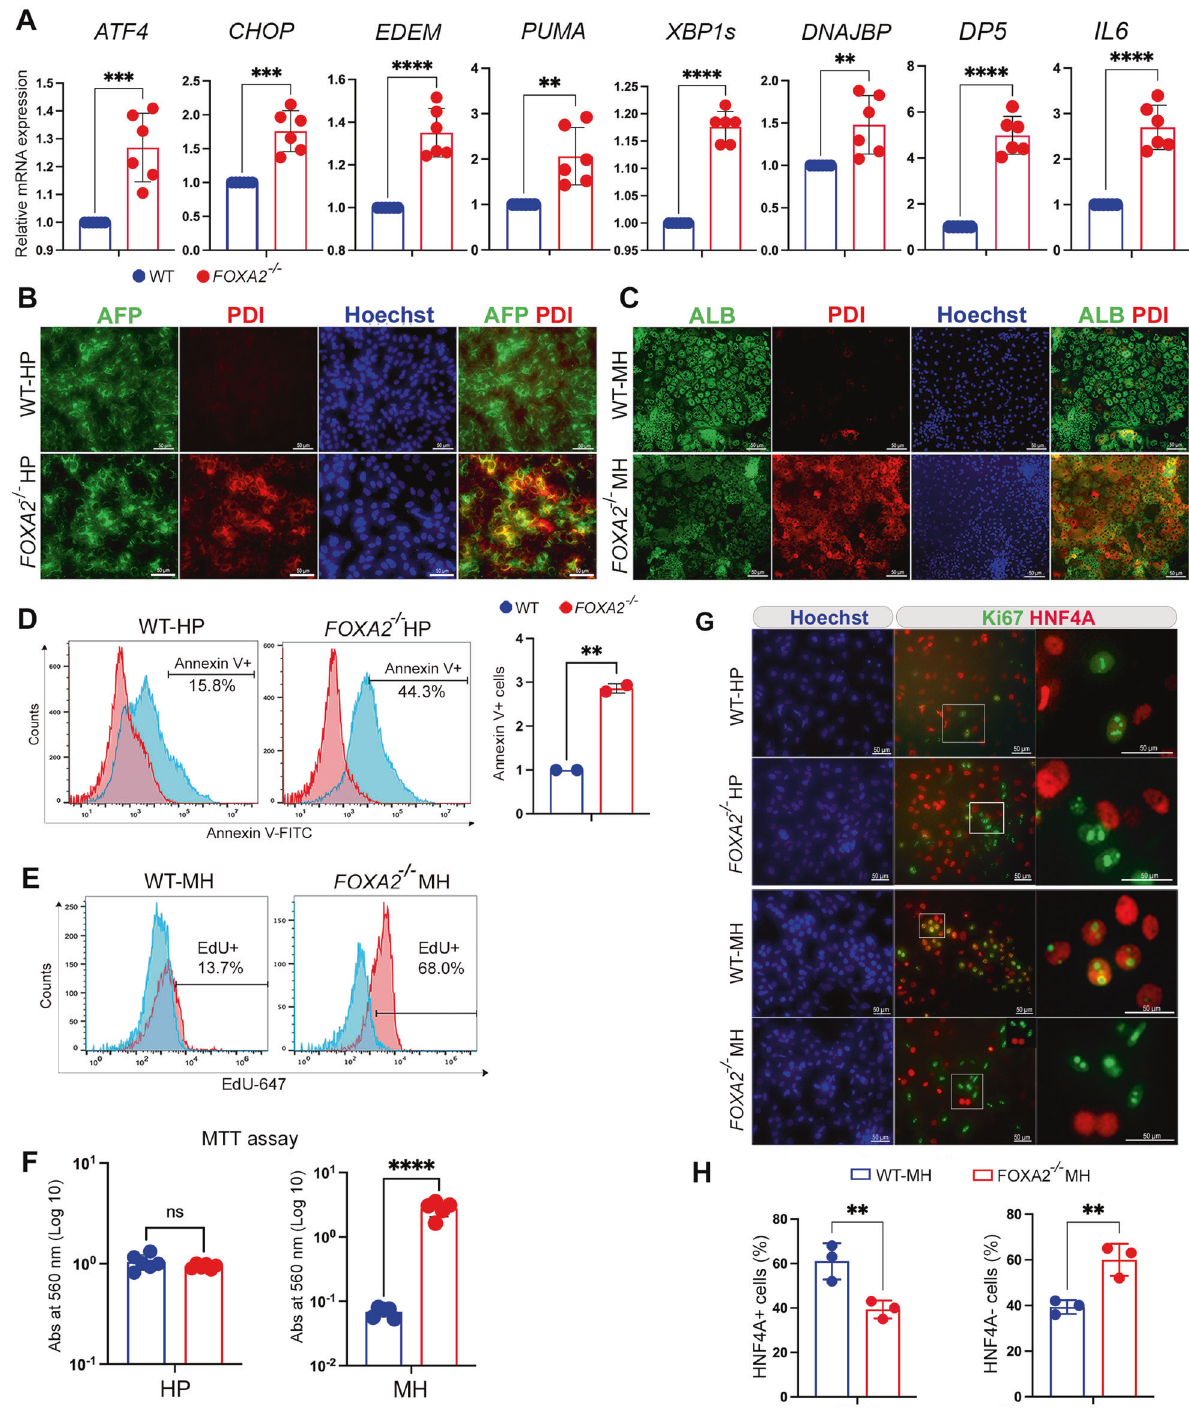
Fig. 3 Effect of FOXA2 ablation on ER-stress markers, apoptosis, and proliferation in iPSC-derived hepatocytes. A RT-qPCR analysis showing the expression of ER stress genes, ATF4 , CHOP , EDEM , PUMA , XBP1s , DNAJBP , DP5 , and IL6 in hepatic progenitors (HP) derived from FOXA2 − / − iPSCs and WT controls ( n = 6). B Immuno fl uorescence showing co-expression of ER stress marker, PDI, with AFP in FOXA2 − / − HP ( B ) and with ALB in FOXA2 − / − MH ( C ) compared to WT controls. D Flow cytometry analysis of cell apoptosis (Annexin V + cells) showing a signi fi cant increase in apoptosis in HP derived from FOXA2 − / − iPSCs compared to those derived from WT-iPSCs ( n = 2). E Flow cytometry analysis of EdU incorporation showing a dramatic increase in cell proliferation (EdU + cells) in mature hepatocytes (MH) derived from FOXA2 − / − iPSCs in comparision to those derived from WT-iPSCs ( n = 3). F Relative MTT levels in FOXA2 − / − HP and FOXA2 − / − MH relative to WT controls, quanti fi ed by measuring absorbance at 560nm ( n = 5). G Double immuno fl uorescence staining for Ki67 (proliferation marker) and HNF4A (hepatic marker) in FOXA2 − / − HP and FOXA2 − / − MH relative to WT controls. Squares indicate cells magni fi ed in the right panels. Note clear distinction between Ki67 and HNF4A in HP and MH lacking FOXA2. H Percentage of HNF4A + (hepatocytes) and HNF4A − (non-hepatocytes) cells in FOXA2 − / − MH compared to WT controls. The total number of cells was determined using Hoechst staining ( n = 3). The data are presented as mean ± SD. * p < 0.05, ** p <0.01, *** p < 0.001.